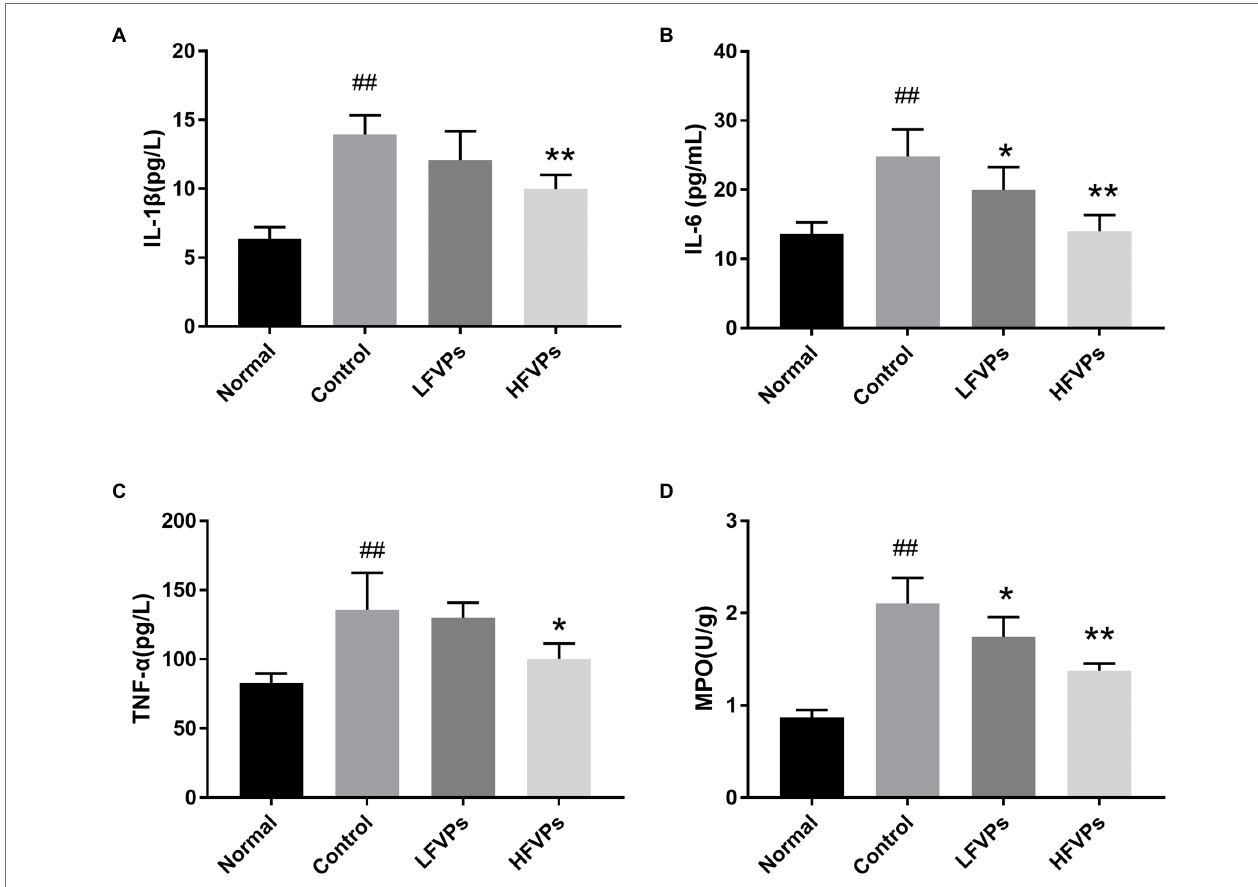
FIGURE 5 | Effect of FVPs on hepatic inflammation. The bar charts show the results obtained for the hepatic content of (A) IL-1 β , (B) IL-6, (C) TNF- α , and (D) myeloperoxidase (MPO; as measured using ELISA kits). The data are presented in the form: mean ± SD (with eight mice per group). The symbols # and ## represent significance levels of p < 0.05 and p < 0.01 compared to the Normal group, respectively. Similarly, * and ** represent p < 0.05 and p < 0.01 compared to the Control group,